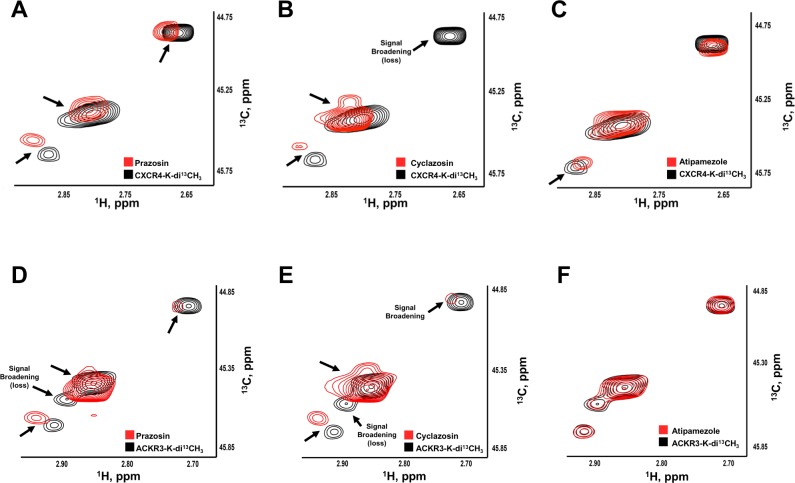
Prazosin and cyclazosin induce chemical shift changes in the NMR spectra of CXCR4 and ACKR3 in membranes.1H-13C HSQC spectra of reductively methylated CXCR4 (A-C) and ACKR3 (D-F) membrane preparations were recorded without (black) and with (red) 200 μM prazosin (A/D), cyclazosin (B/E) or atipamezol (C/F). Black arrows indicate significant differences in chemical shifts or broadening (loss) of the signal.